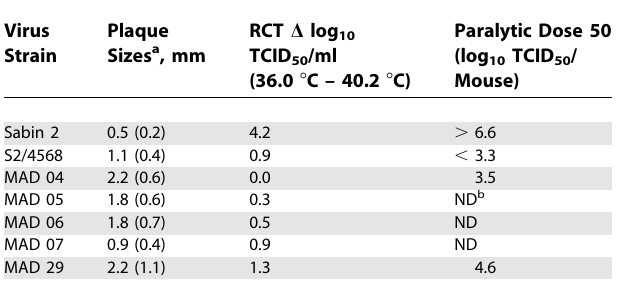
Table 2. Antigenic Structure of the VDPVs MAD 04 and MAD 29 Antigenic Site a MAb